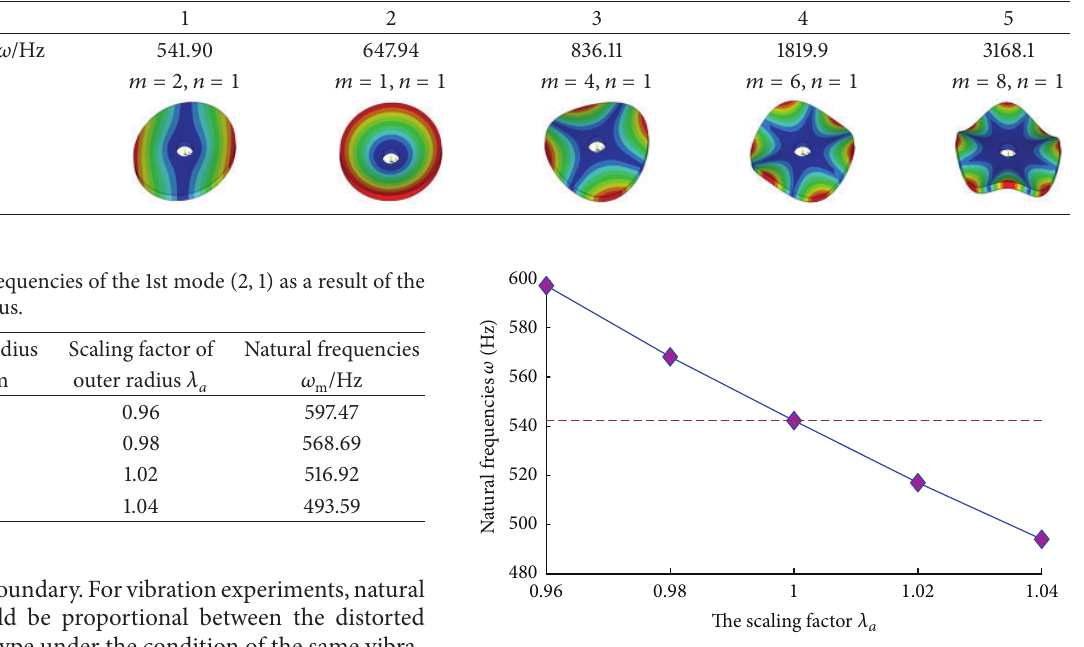
Table 2: The dynamic characteristics of the prototype.